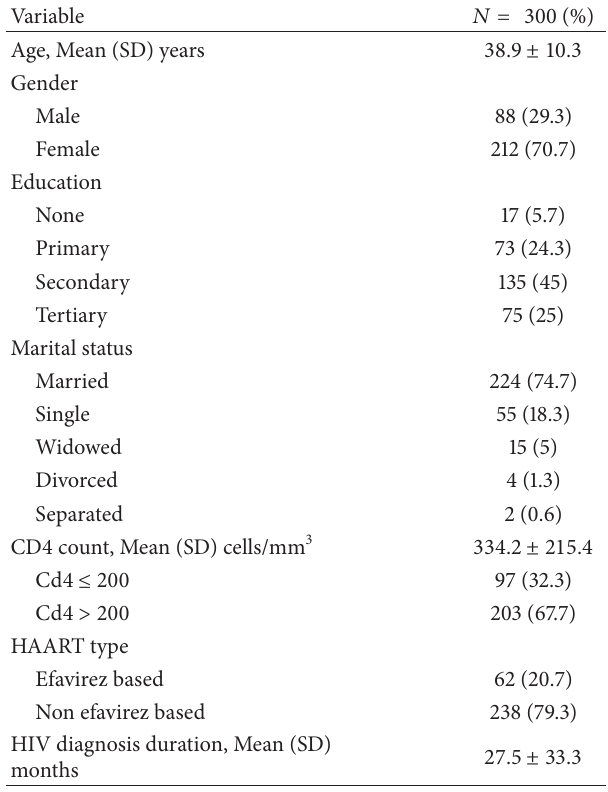
Table 1: Demographic and clinical characteristics of study popula-